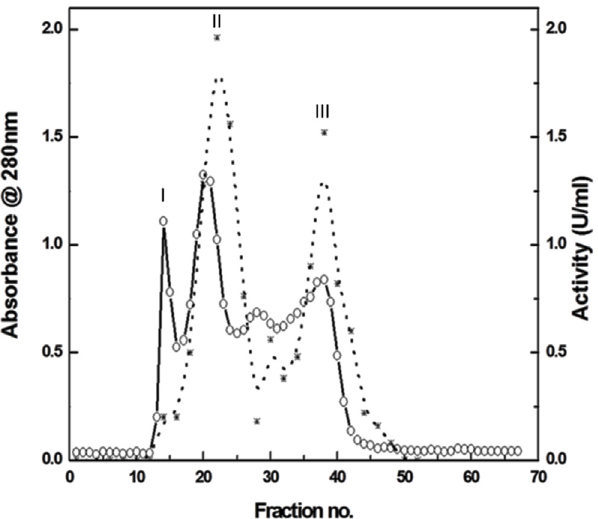
Fig 1. Size exclusion chromatography profile of cupincin on sephadex G 150 column. (o-o) protein content ( * - * ) protease activity. The column was pre equilibrated with 50mM Tris-HCl buffer, pH 7.5. A flow rate of 1mL/10 min was set. Fractions were detected at 280 nm. Peak II being highest in terms of proteolytic activity is pooled, concentrated and used for further experiments as described in the materials and methods section. Denatured haemoglobin was used as substrate for activity measurements.